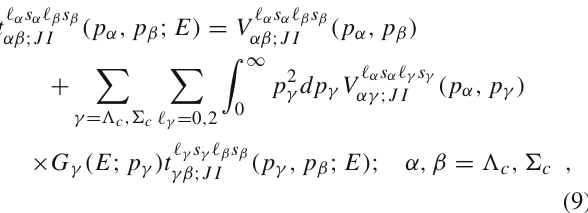
((cid:13) (cid:2) , s (cid:2) ) that c c